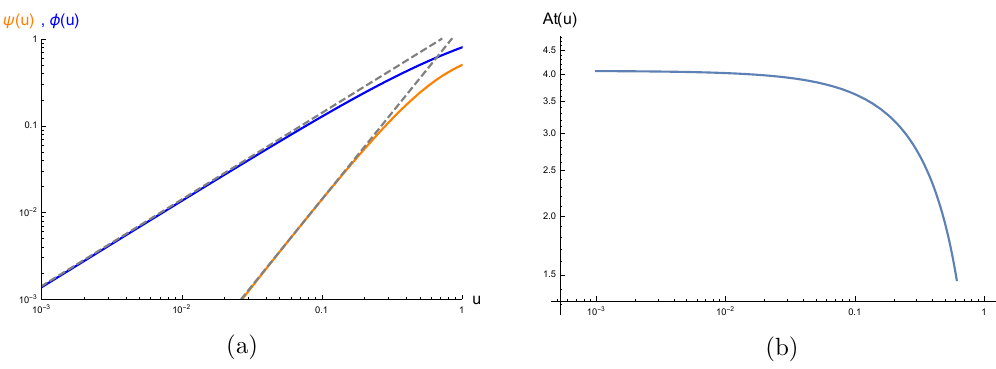
Figure 1. A sample solution for (cid:11) 1 = 1 = (cid:11) 2 , (cid:12) = 0 : 6 and (cid:21) = 0. The dashed lines in (a) are u and u 2 respectively, appearing as straight lines in the Log-Log plot. Shooting has been performed to ensure